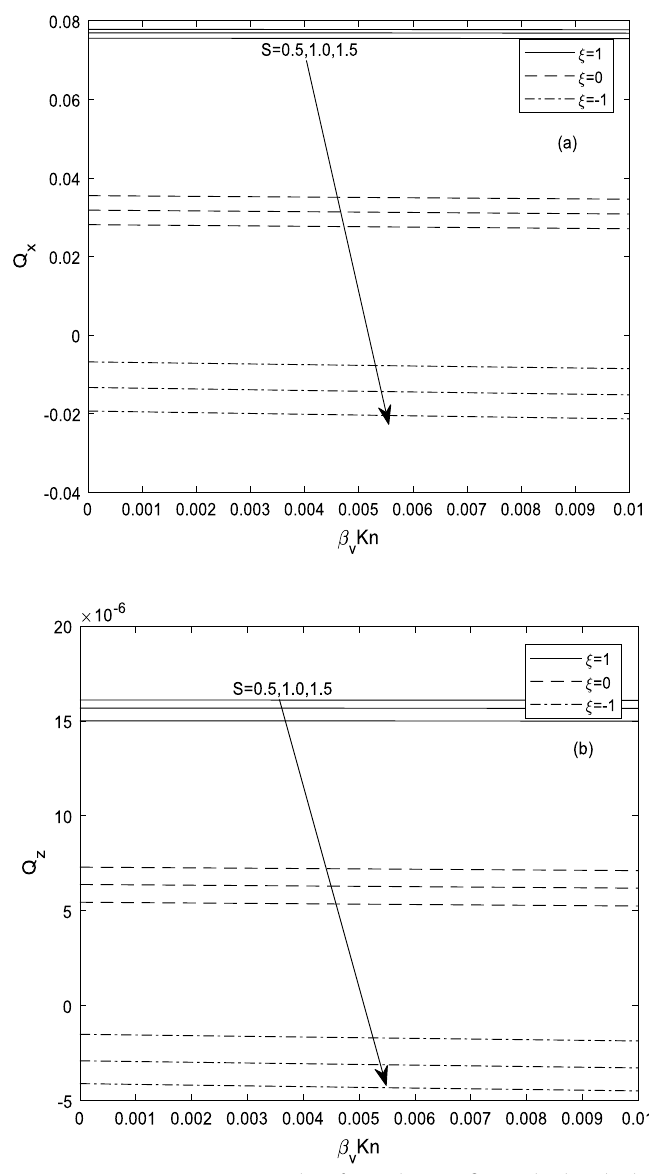
Fig. 14 a Suction/injection parameter (positive value of S ) on the main flow and induced volume flow rate for β v Kn = 0.05, M = 2,ln = 1.667, β i = 3.0, β h = 0.10 and Pr = 0.71 . b Suction/ injection parameter (positive value of S ) on the main flow and induced volume flow rate for β v Kn = 0.05, M = 2,ln = 1.667, β i = 3.0, β h = 0.10 and Pr =